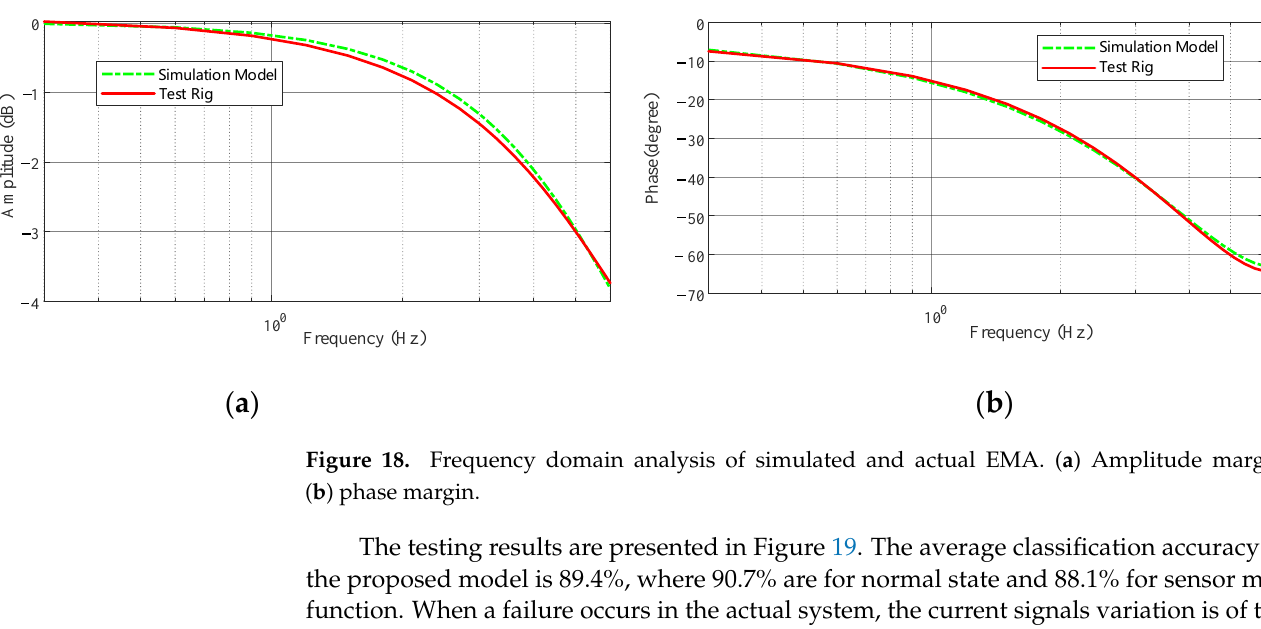
Figure 17. Time domain analysis of simulated and actual EMA. ( a ) Response to a 1 Hz sinusoidal signal; ( b ) response error.